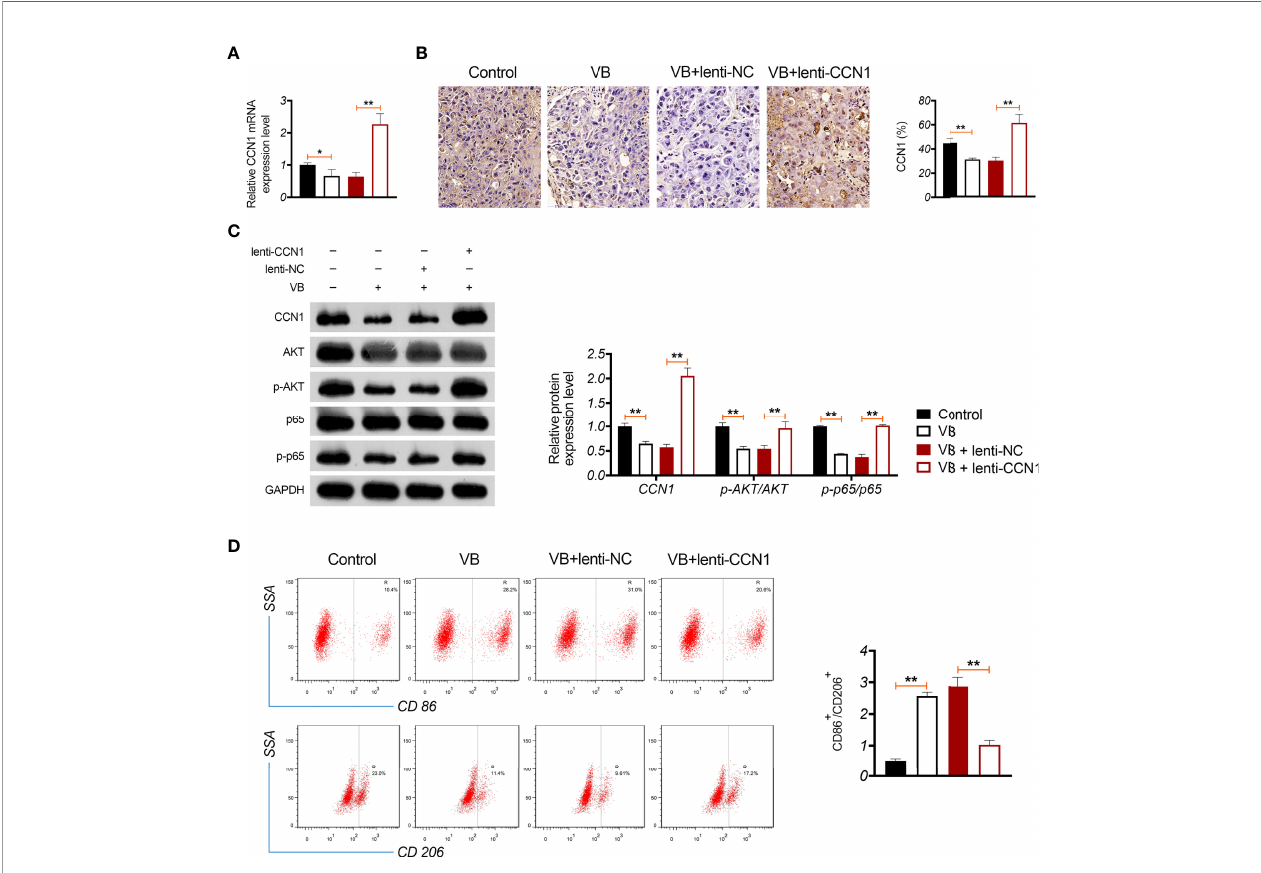
FIGURE 7 | VB promotes M1 polarization in OC tissues through inhibiting CCN1-mediated AKT/NF- k B pathway. (A) The relative mRNA expression of CCN1 in tumour tissue was detected by RT-qPCR. (B) The CCN1 protein expression was detected in tumour tissue by immunohistochemistry. (C) The protein expression levels of CCN1, p-AKT/AKT, and p-p65/p65 were detected by western blotting in tumour tissue. (D) The ratio of CD86 + /CD206 + in tumour tissues was measured by fl ow cytometry. Tumour tissue was removed from tumour xenograft model mice subcutaneously injected with A2780 cells. Each treatment was replicated three times. Error bars represent mean ± SD; * P < 0.05and ** P <